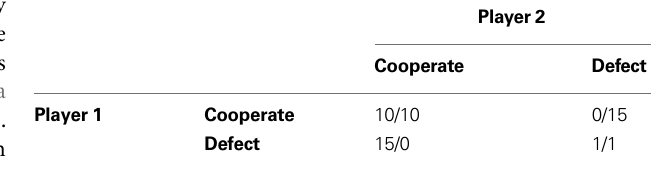
Table 1 | An example payoff matrix of two-player Prisoner’s dilemma game in which each player can choose either to ‘cooperate’ or ‘defect’. The Left-side numbers represent the payoffs for the fi rst player and the right-side numbers represent the payoffs for the second. Payoffs are symmetric, and chosen so that the sum of the payoffs is greatest when both choose cooperate and least when both players choose defect. However, each player earns the most if he chooses to defect when the other cooperates. Thus, the unique subgame perfect Nash Equilibrium of this game is for both players to